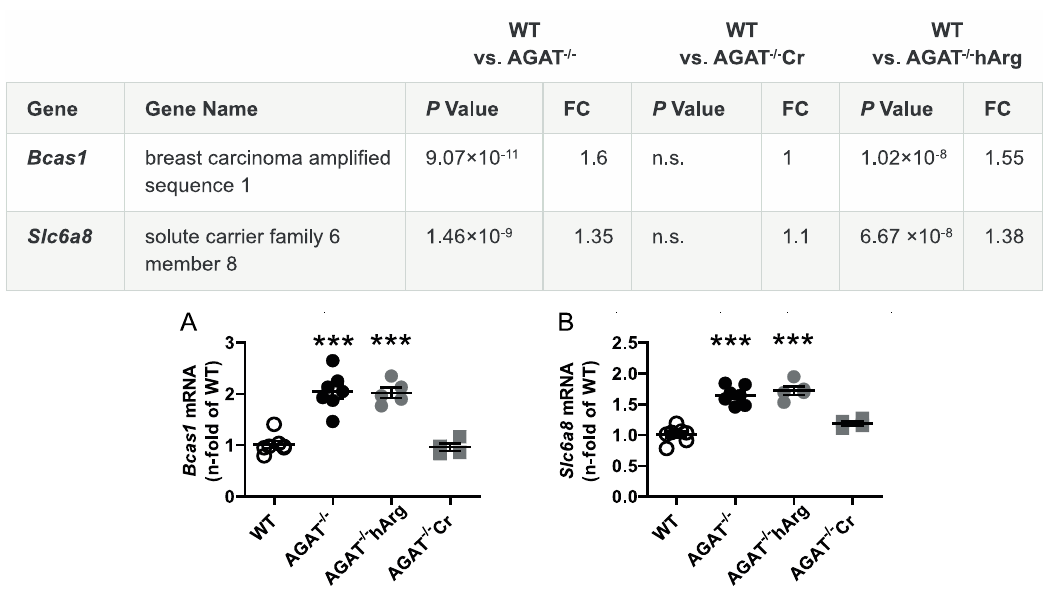
Figure 3. Validation of potential creatine-dependent candidate genes by qPCR. Relative mRNA expression of Bcas1 ( A ) and Slc6a8 ( B ) in the brain. Each data point represents an individual mouse. *** p < 0.001 versus WT. WT ( n = 7), AGAT − / − ( n = 7), AGAT − / − hArg ( n = 5), AGAT − / − Cr ( n = 4). The table shows the respective microarray data. Abbreviations: FC, fold change; n.s., not significant.